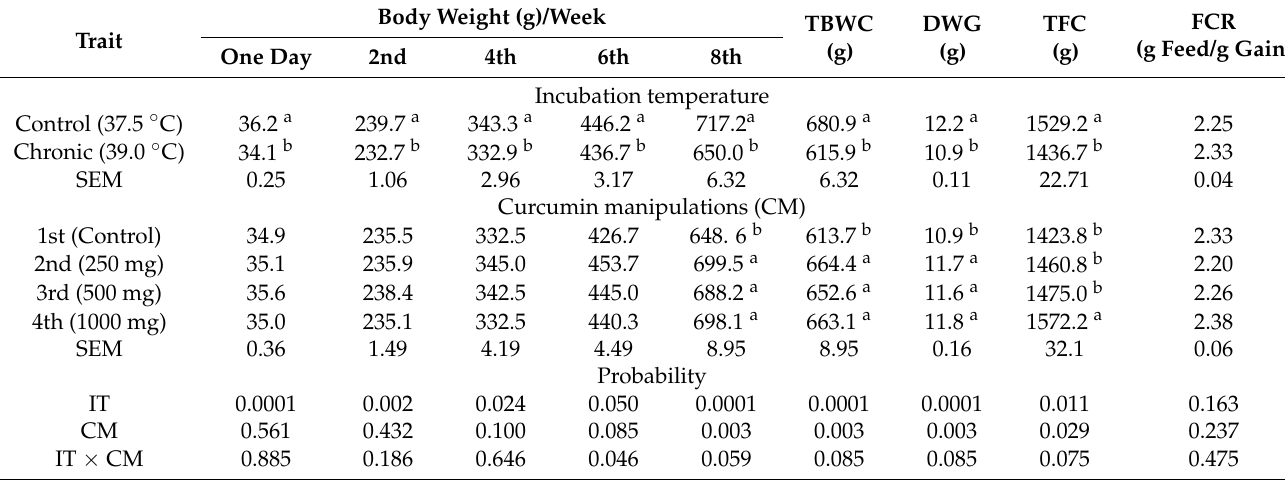
a,b Means with different superscripts in the same row are significantly different ( p < 0.05). DWG (g), daily weight gain; TFC (g), total feed consumption; FCR, feed conversion ratio; IT, incubation temperature; CM, curcumin manipulations; SEM, standard error of mean. The values are the average of group data.